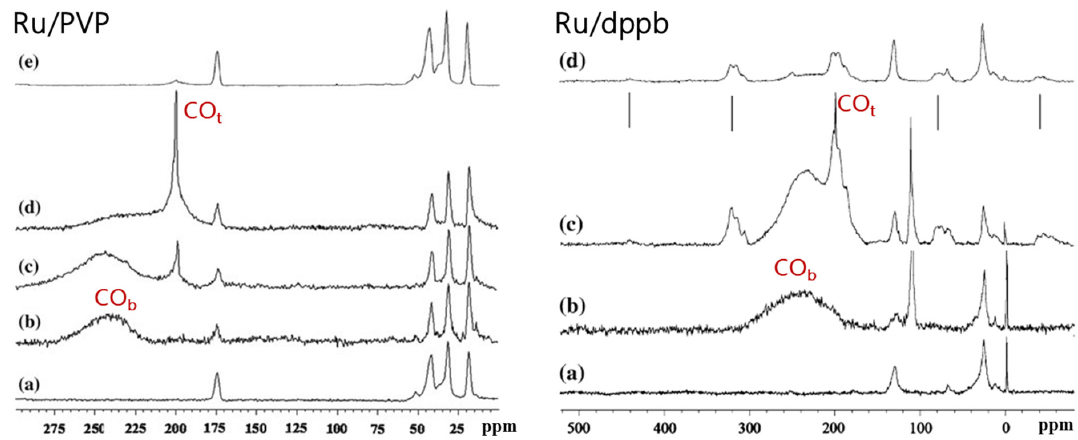
Figure 7. Left: 13 C MAS-NMR of Ru / PVP after exposure of 0.5 bar 13 CO at 0 ( a ), 2 ( b ), 6 ( c ) and 12h ( d ). 13 C CP-MAS NMR of Ru / PVP ( e ). Right: 13 C MAS-NMR of Ru / dppb after exposure of 13 CO pressure at 0 ( a ), 2 ( b ) and 12 h ( c ) of reaction time. 13 C CP-MAS NMR of Ru / dppb ( d ). Spinning side bands are indicated below the spectrum. Extracted with permission of reference 31. Copyright 2010 Springer.